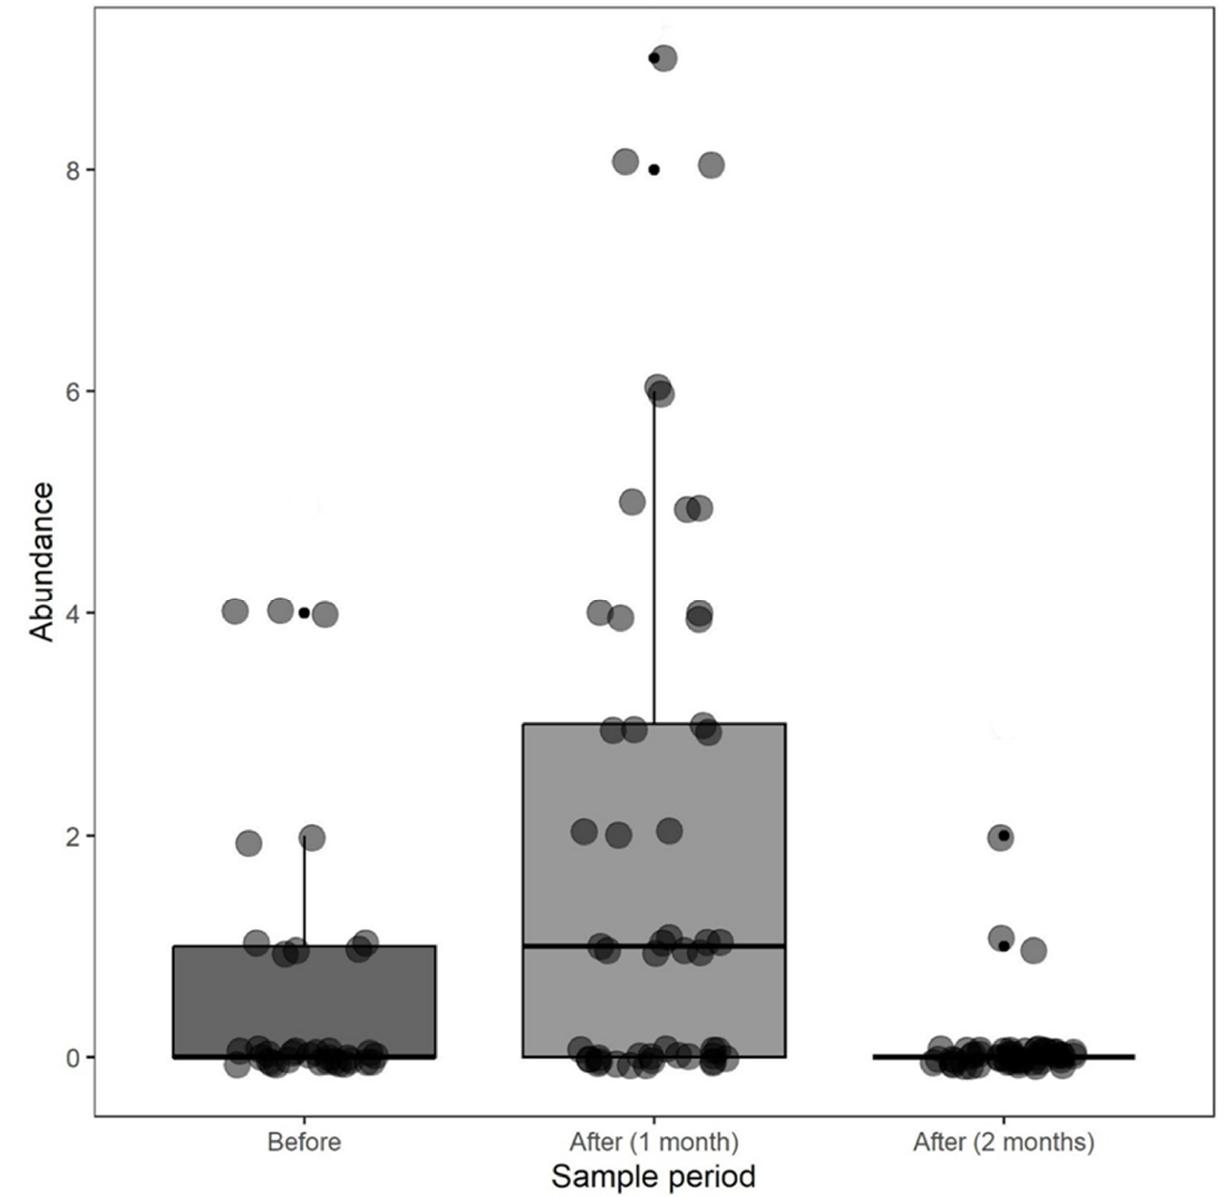
Figure 5. Abundance of sun spiders before, one month after, and two months after fires in 2021 in the Kadiwéu Indigenous Reserve, Porto Murtinho, Mato Grosso do Sul State, Brazil. We found differences in the NDVI as a function of the days after the fires at the sampling sites in 2021 (one-way repeated measures ANOVA, F = (2, 32) 13.19, p < 0.001), with the lowest index values at 10–25 days after fire (comparison between pairs with Bonferroni correction (0.299 ± 0.065). The NDVI increased after 30 days after fires (Table 1). Table 1. Study site locations and Normalized Difference Vegetation Index (NDVI) Values during, 10–25 after, and 30 or more days after fire.